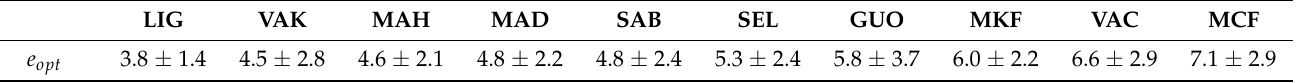
Table 4. The Mean ± STD of the Errors for Each SFA for Optimal Parameter Values